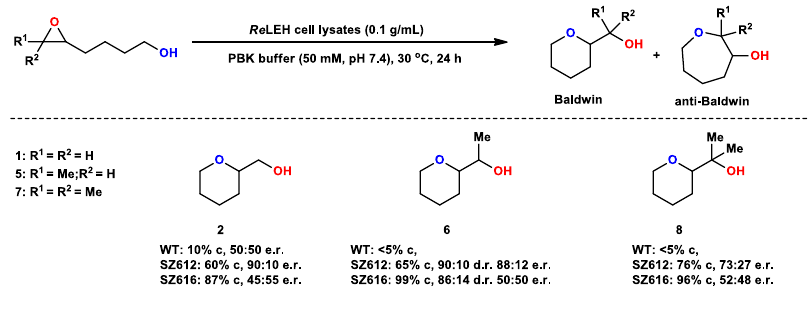
Fig. 3 | Substrate scope ofBaldwin reactions catalyzed by LEH mutants. Reaction conditions: LEH (0.1g/mL wet cell), Substrates (5mM), PBKbuffer (50mM, pH 7.4), Lysozyme (1mg/mL), DNase I (6U/mL), 0.5mL total volume, 30°C, 1000rpm,